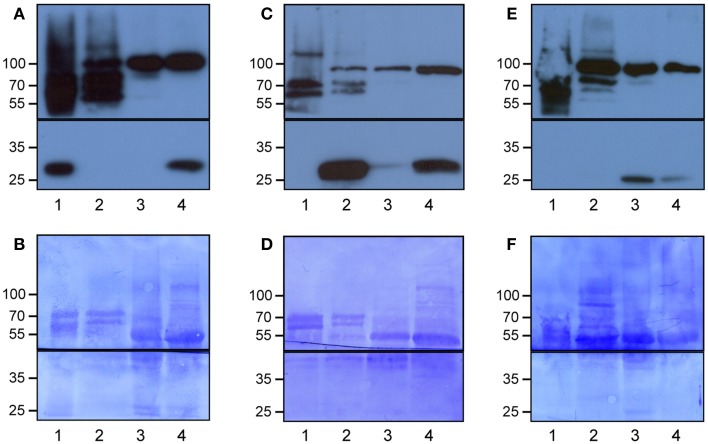
Specific enrichment of the epidermal, vascular and mesophyll tissues using the Meselect method. The different tissue types were separated using leaves of GAL4-GFP enhancer trap lines with GFP expression specifically in the epidermal (A,B), vascular (C,D) or mesophyll (E,F) tissue. The protein blots were probed with antibodies against GFP (lower panels in A,C,E) and HSP90 (upper panels in A,C,E) as loading control, and afterwards stained with Coomassie (B,D,F) to show protein loading. The black lines indicate where the membranes were cut. Lane 1, epidermal tissue proteins; 2, vascular tissue proteins; 3, mesophyll tissue proteins; and 4, total leaf proteins. At the left, the molecular weight is indicated.